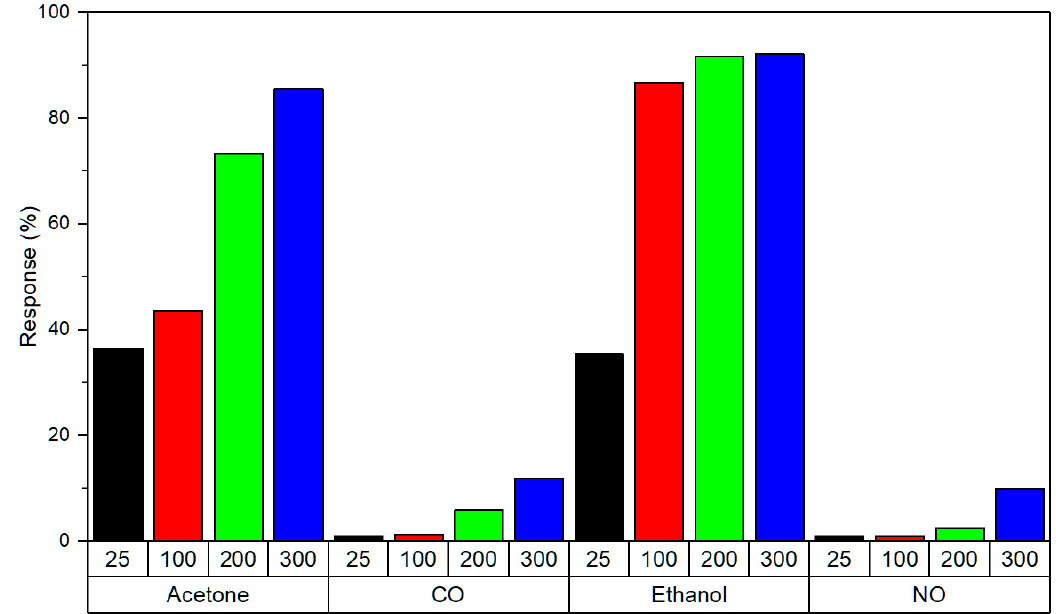
Figure 7. Sensor responses to 2 ppm ethanol, 4 ppm acetone, 5 ppm CO, and 100 ppb NO at different operating temperatures (25, 100, 200, and 300 °C).